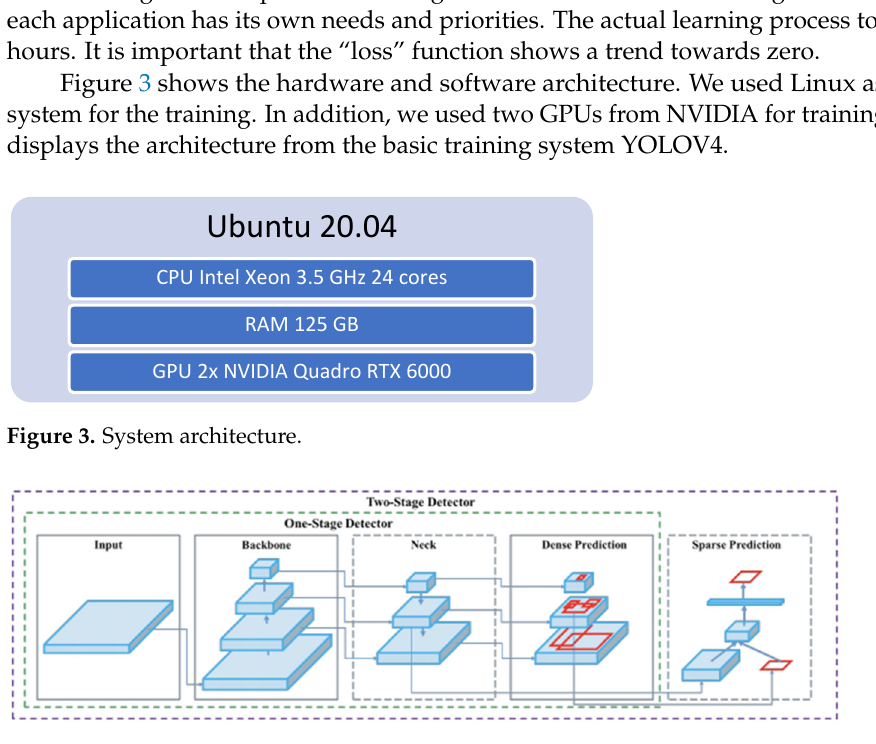
Figure 2. Annotation sample two. Black boxes are annotated R. obtusifolius leaves.